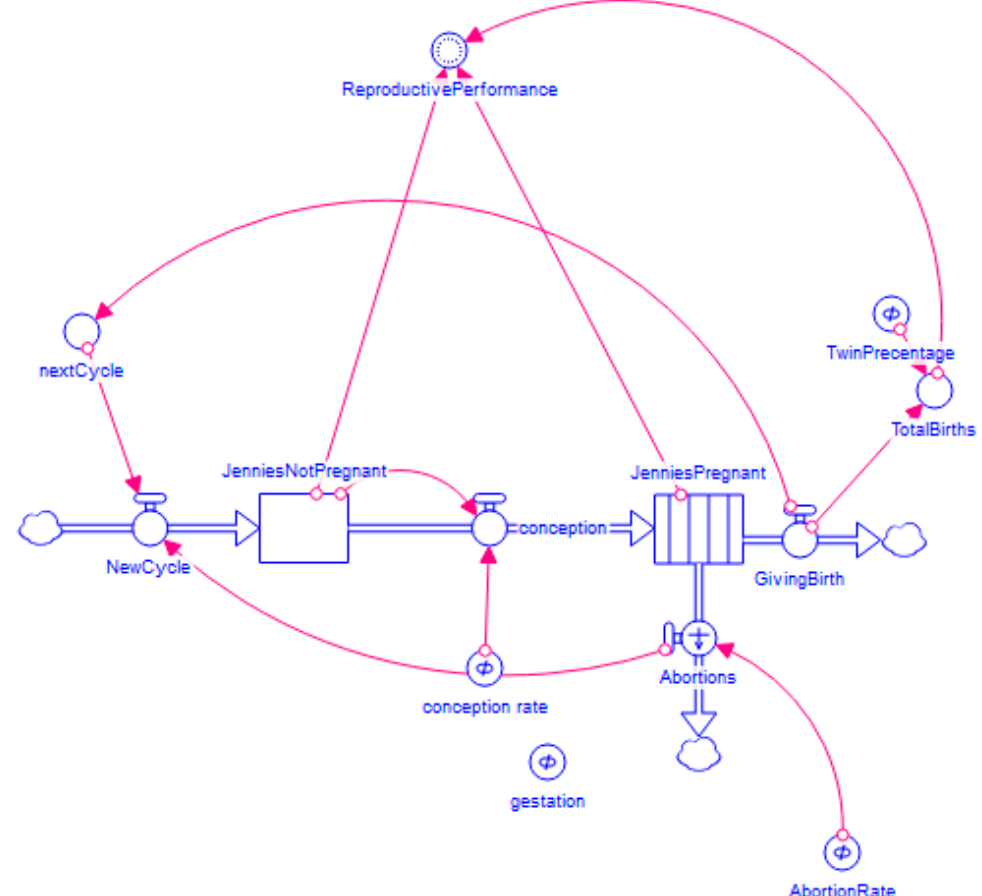
Figure 2. Stock and flow diagram of the reproductive performance model.